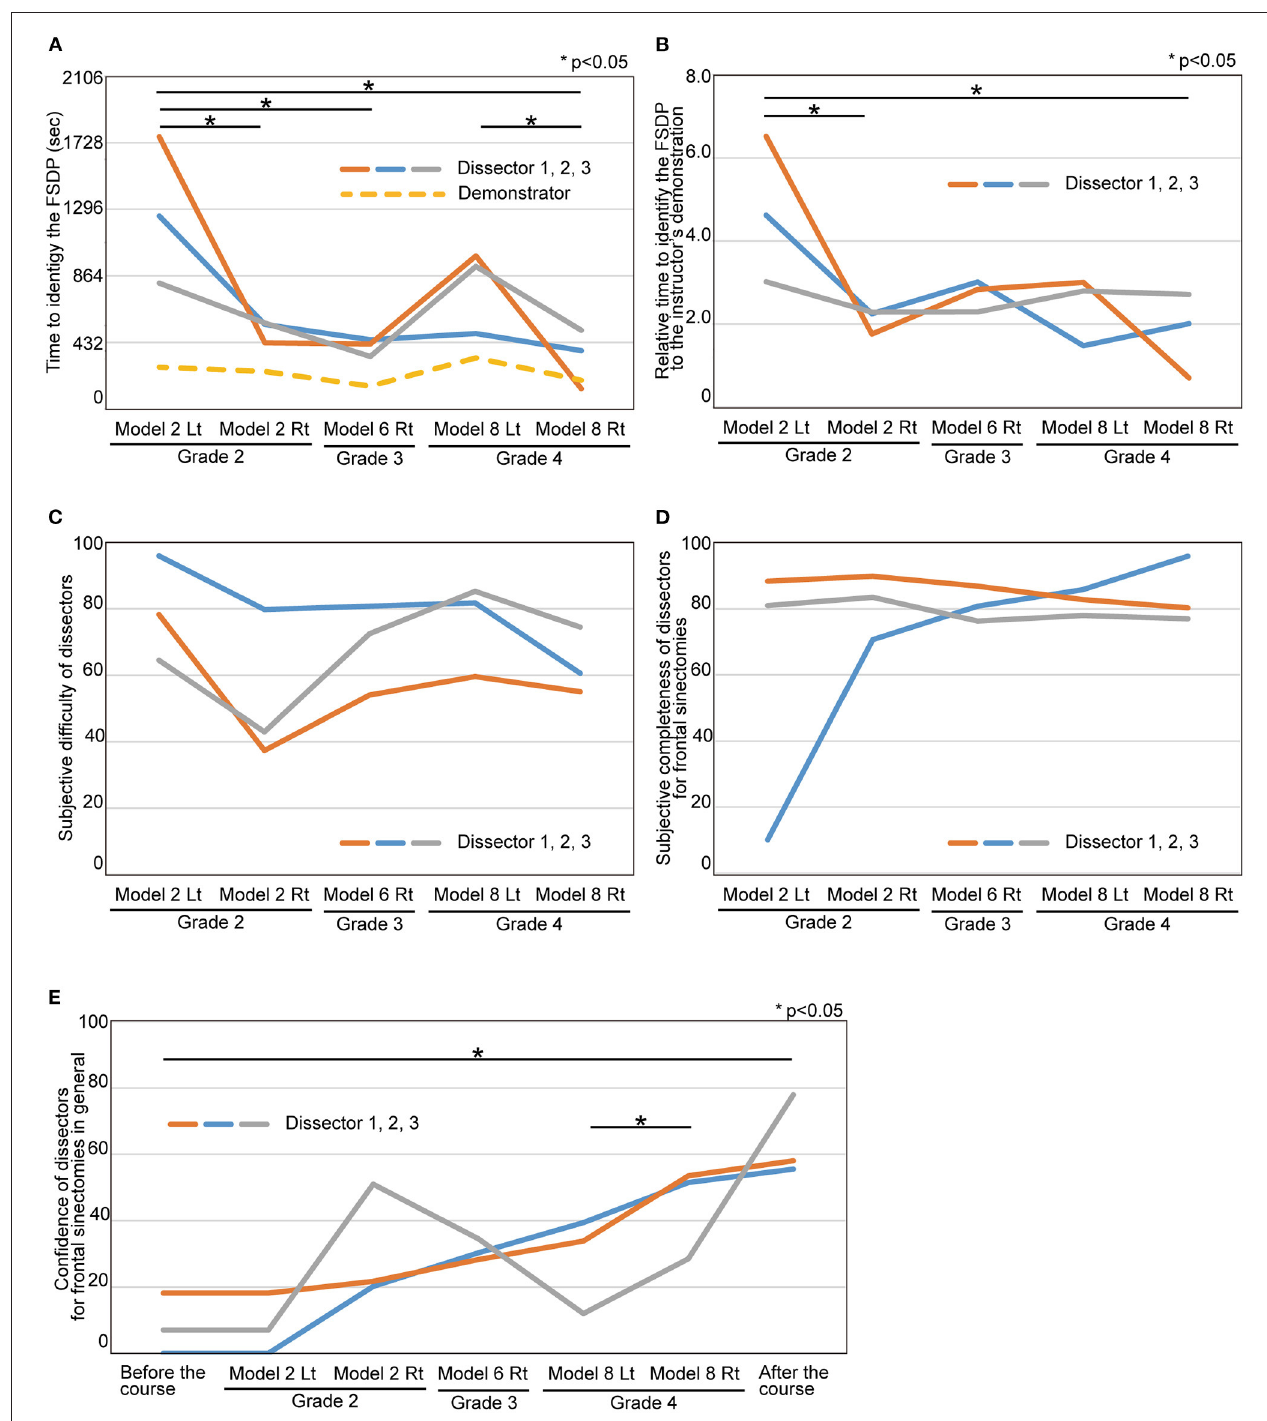
FIGURE 2 | The remote endoscopic surgery training course was objectively and subjectively beneficial in improving the dissectors’ surgical techniques. (A) The time to identify the FSDP. It was defined as the time interval from starting to resect the anterior wall of ANC to identify and insert a ball probe tip to FSDP at the height of the top of ANC. P -values for indicated comparisons were determined by t -test. * p < 0.05. (B) The relative time to identify the FSDP to the instructor’s demonstration. P -values for indicated comparisons were determined by t -test. * p < 0.05. (C) The subjective difficulty of the surgeries that the dissectors were perceiving during the dissection. (D) The subjective completeness of frontal sinusotomy during the dissection. (E) The confidence for frontal sinusotomy in general before, during, and after the course. P -values for indicated comparisons were determined by t -test. * p < 0.05.